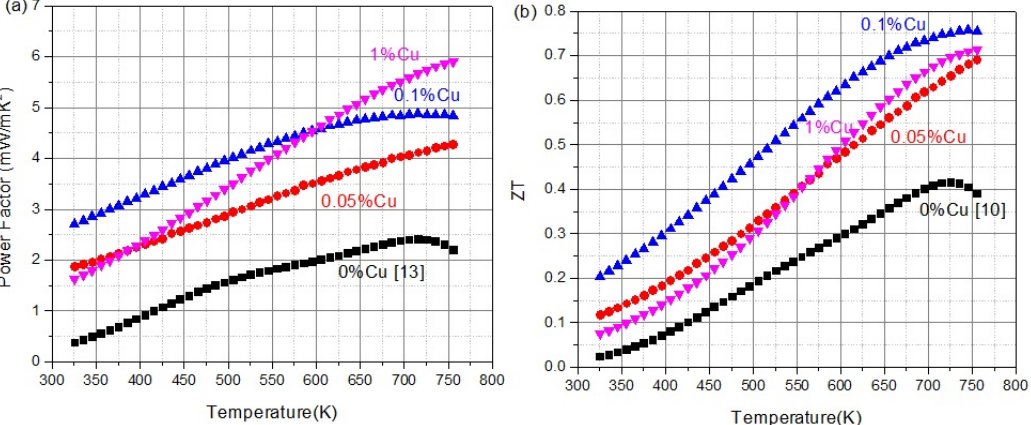
Figure 6. ( a ) Power factor of the ( b ) ZT of TiNi 1- x Cu x Sn with a maximal ZT of 0.75 and average ZT of 0.5 from 325 to 750 K for the 0.1% Cu-doped sample